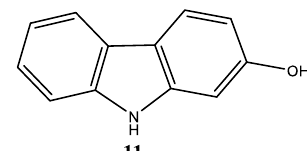
Figure 7. Structure of 2-hydroxycarbazole ( 11 ).